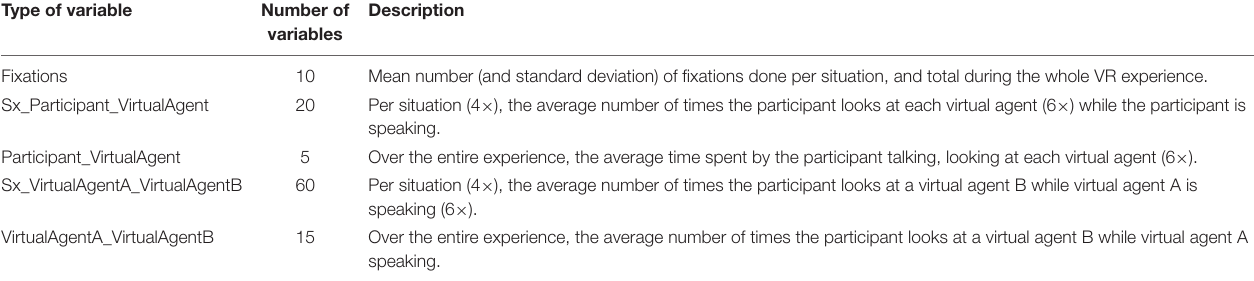
TABLE 3 | Description of the variables obtained from the eye-tracking data. Type of variable Number of variables